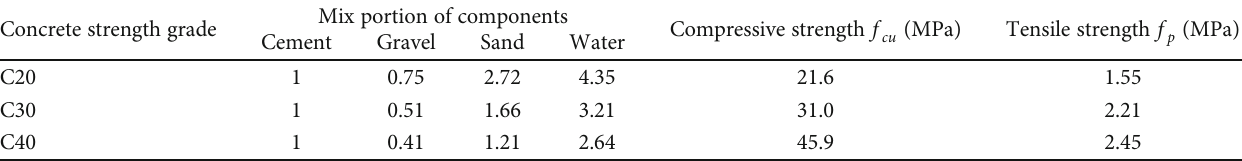
Table 2: Components and mix proportion of the concrete.